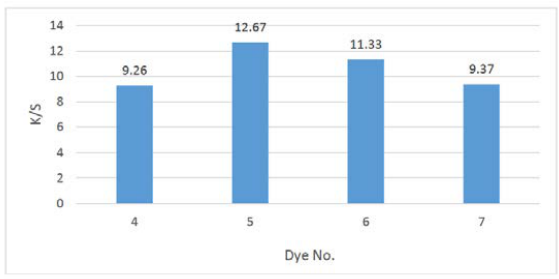
Figure 1. Comparison of K/S values for the synthesized disperse dyes 4 – 7 series.